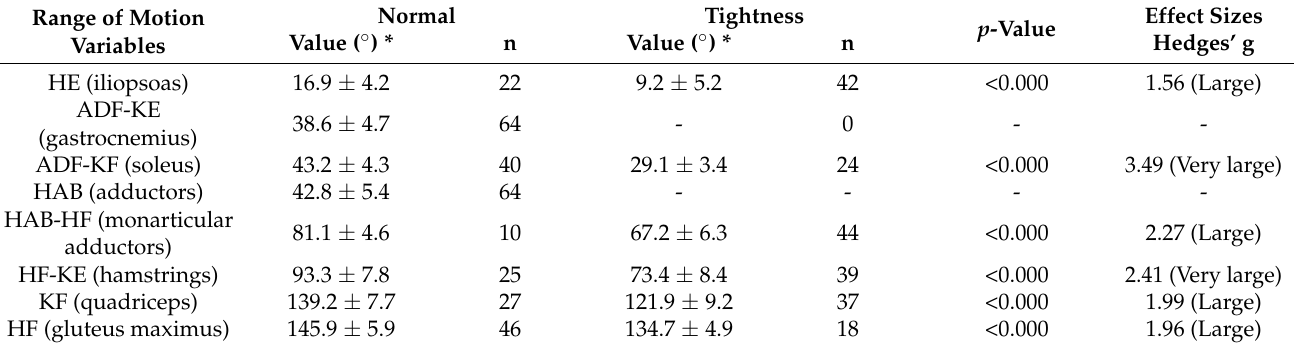
Table 2. Range of motion results classified by muscle tightness reference values in 64 competitive basketball players.